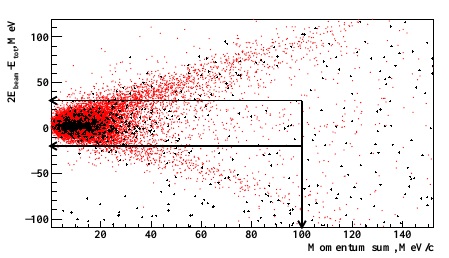
Figure 1. Momentum dependence for track energy deposition in the calorimeter. The red line is the e /π separation criterion.